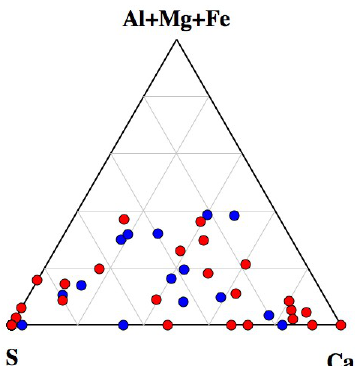
Figure 9. Ternary diagram of (Al + Mg + Fe)–S–Ca for Ca-rich and sulfate particles analyzed by SEM-EDX analysis. Data are pre- sented in relative atomic proportions. The circles indicate the non- active (red) and IN active particles